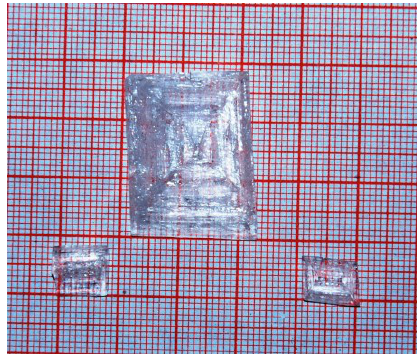
Figure 1. As grown CLMHCl